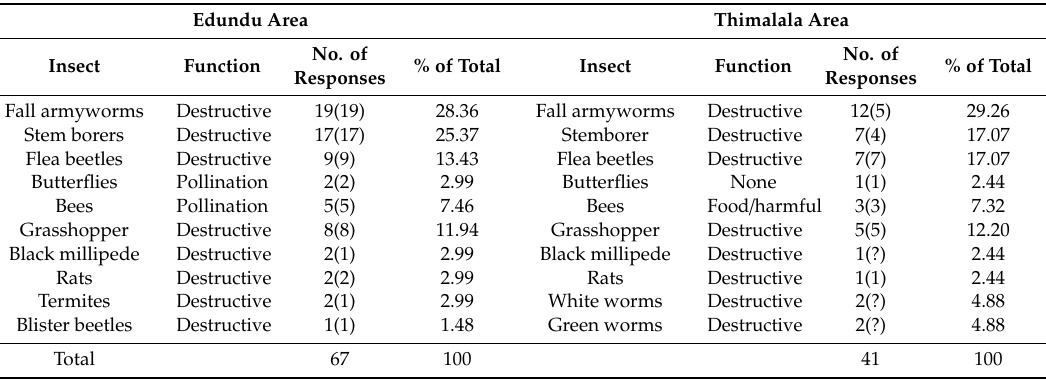
Table 5. List of insects identified as most important in farming activities during farm-level PPGIS activities (Edundu = 35 participants, Thimalala = 33 participants). Farmers named (in local language), identified and geolocated the insect on their farms using GNSS devices and their findings were corroborated by the research